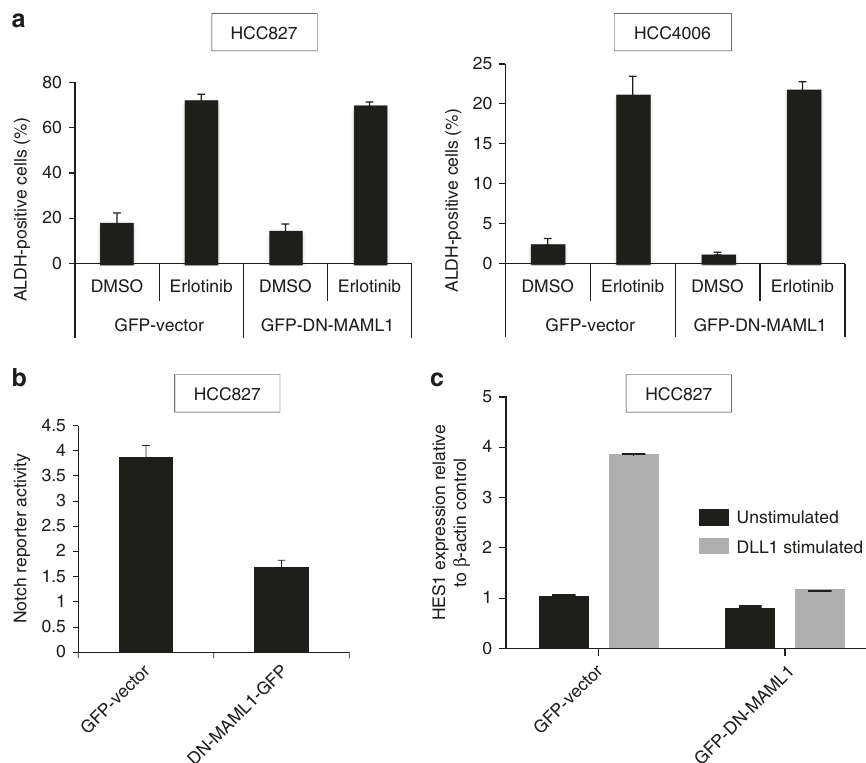
Fig. 2 EGFR TKI-induced ALDH activity does not require MAML activity. a HCC827 (left) and HCC4006 (right) were stably infected with control vector or DN-MAML1 and treated with DMSO or erlotinib and subjected to ALDH assay. b HCC827 cells that were stably infected with control vector or DN- MAML1 were also treated stably infected with virus expressing notch operating promoter (NOP) reporter and NOP activity was assayed using FACS. c HCC827-Vector or HCC827-DN-MAML1 were grown on plates coated with DLL1-Fc chimera or control (PBS) for 48 h. Total RNA was isolated and HES1 expression was analyzed using qRT-PCR. For ( a ) and ( c ) error bars represent SD from biological triplicates. For ( a ) and ( b ) error bars represent SD from biological triplicates. For ( c ) error bars represent SD from technical